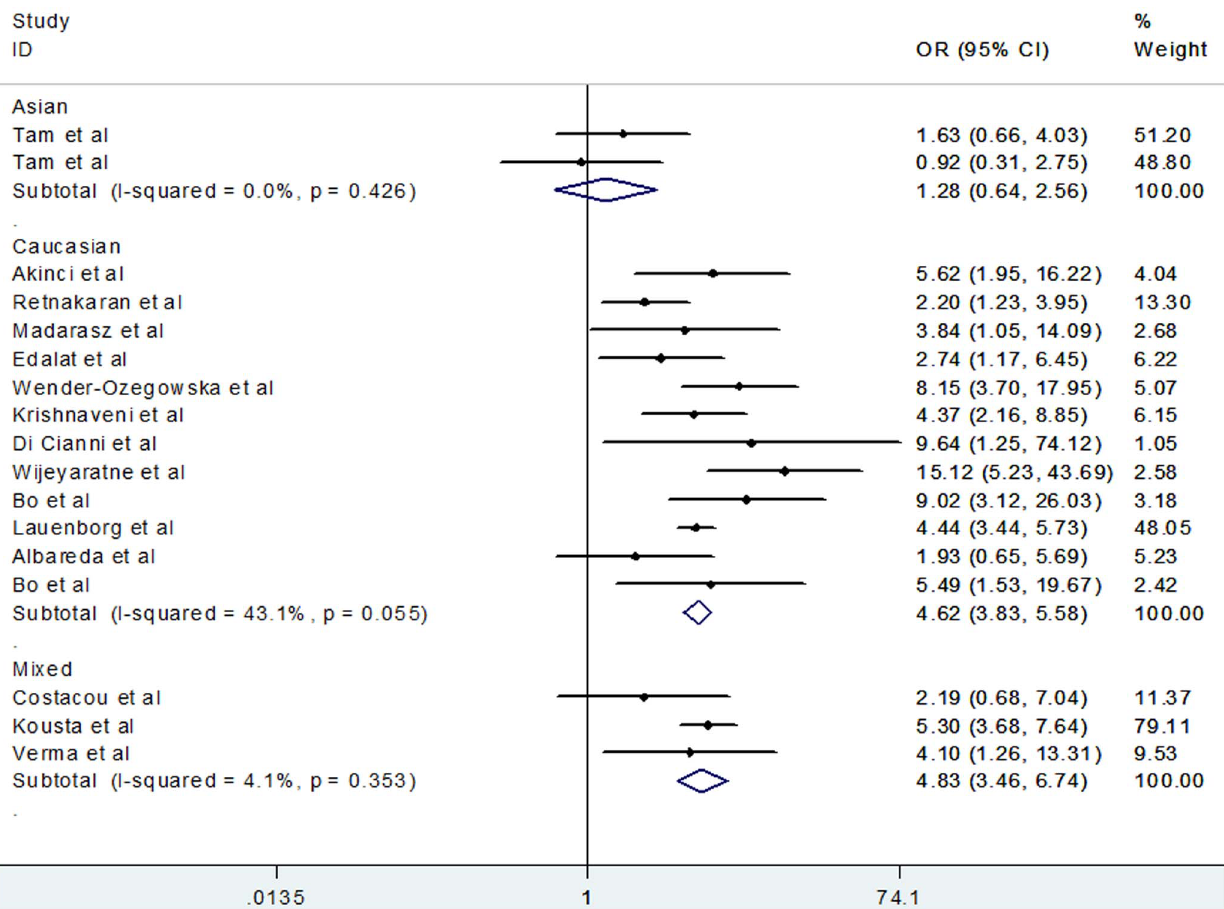
Figure 3. Forest plot of risk of metabolic syndrome after gestational diabetes mellitus grouped by Ethnic origin.